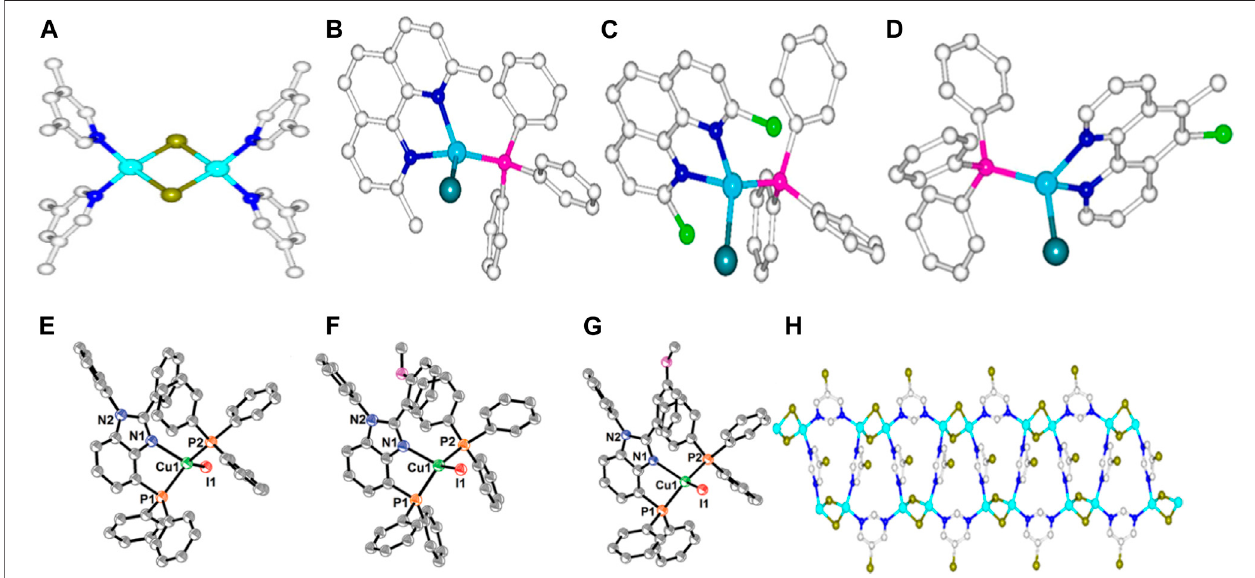
FIGURE 1 | The crystal structures of complexes 1-8.